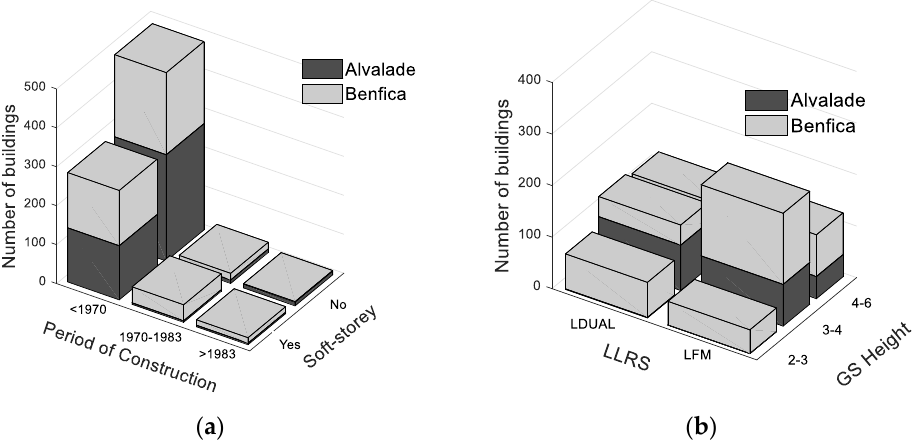
Figure 9. Distribution of buildings in function of the presence of a soft-storey and ( a ) period of construction and ( b ) lateral load resisting system.